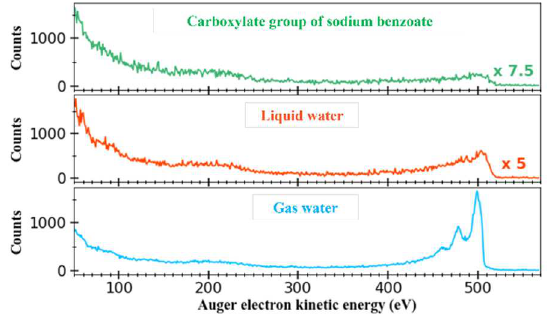
Fig. 3. Photoelectron-filtered spectra with a step of 1 eV, showcasing Auger features. The colors of the spectra refer to the nomenclature of the different oxygens species given in Fig 2. Scaling factors were applied to the liquid and molecular spectra for